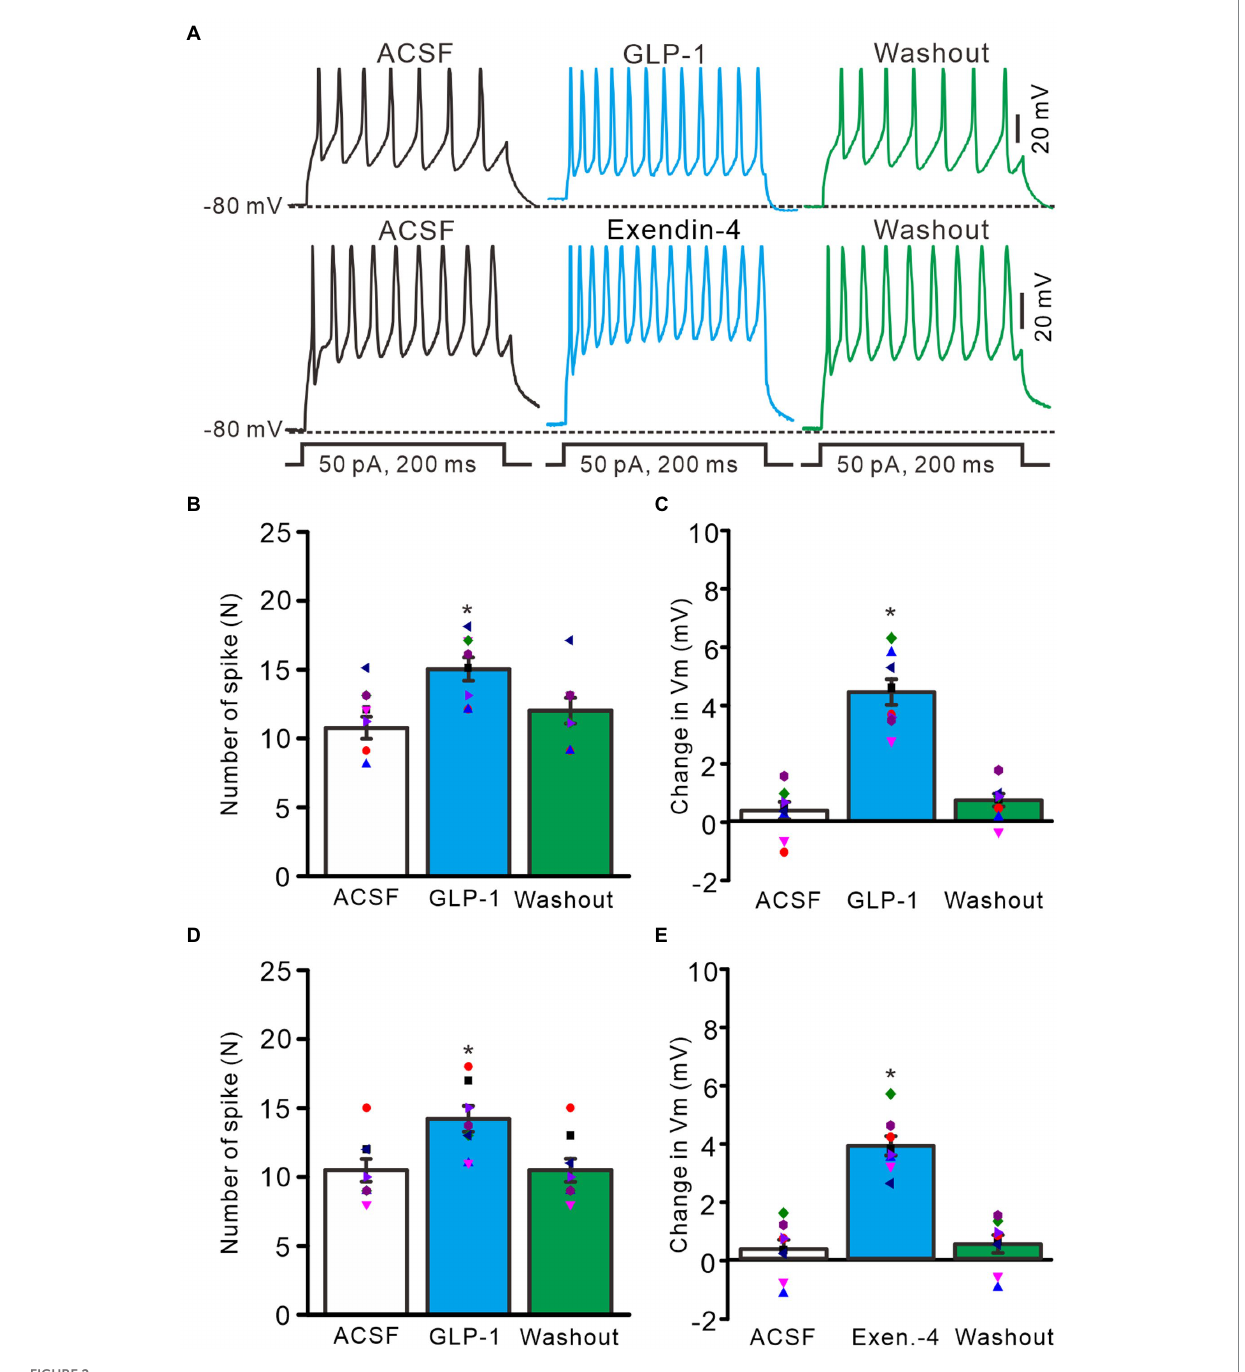
FIGURE 2 GLP-1 and Exendin-4 enhanced excitability of cerebellar PCs. (A) Under current-clamp recording mode (Vm = − 80 mV), the representative traces showing the spike firing elicited by depolarization currents (50 pA, 200 ms) during treatments with ACSF, GLP-1 (100 nM; upper), Exendin-4 (100 nM; lower) and washout. (B) The mean (± S.E.M) with individual data showing the number of spikes evoked by depolarization current during treatments with ACSF, GLP-1 and washout. (C) The mean (± S.E.M) with individual data showing the change of resting membrane potential (Vm) during treatments with ACSF, GLP-1 and washout. (D) The mean (± S.E.M) with individual data showing the number of spikes evoked by depolarization current during treatments with ACSF, Exendin-4 and washout. (E) The mean (±S.E.M) with individual data showing the change of resting membrane potential